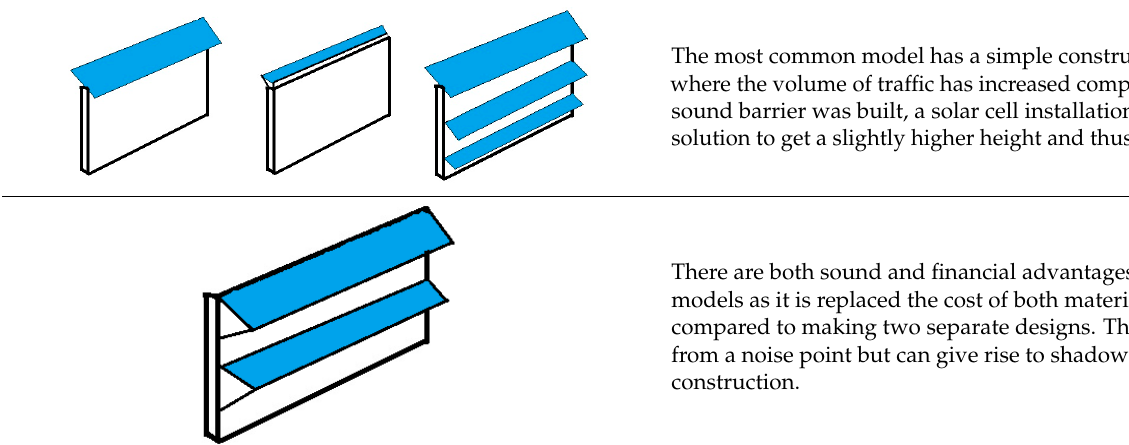
Table 5. PV-integrated sound barrier models.